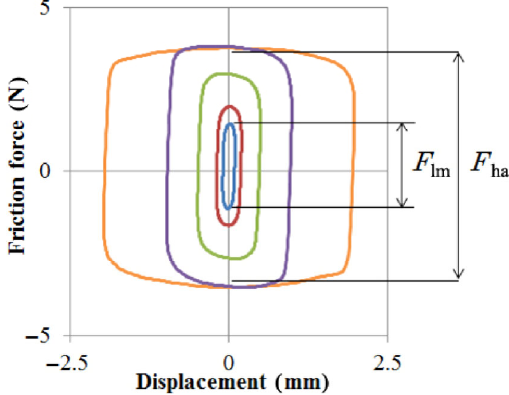
Fig. 6 Calculation concept of the amplitude index